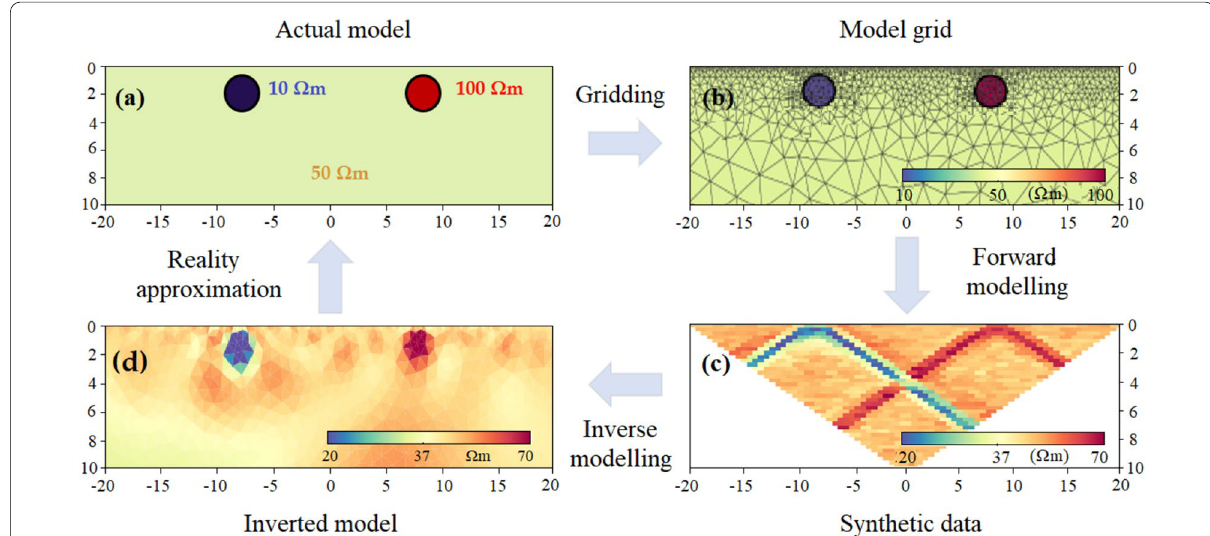
Fig. 5 The general framework of the forward‑inverse modelling of geoelectric data: a synthetic model with two target bodies representing simple subsurface reality, b model discretization, c synthetic measure of apparent resistivity data, and d recovered model